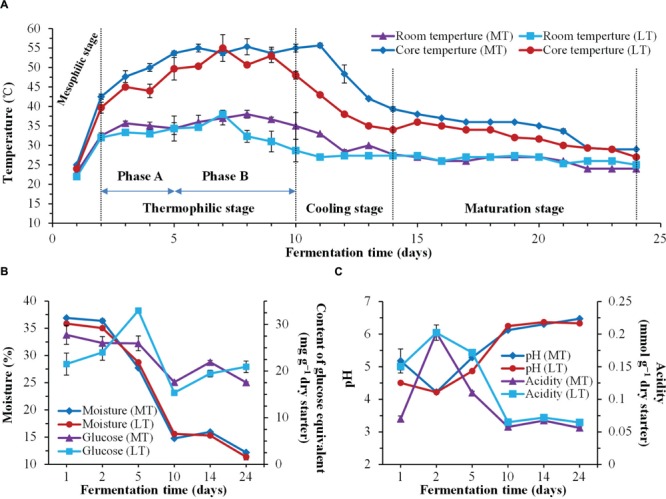
Dynamics of physicochemical characteristics during the MTSSF and LTSSF processes. (A) Changes in room temperature and core temperature of Daqu. (B) Changes in moisture and reducing sugar (calculated as glucose) contents. (C) Changes in pH and acidity.